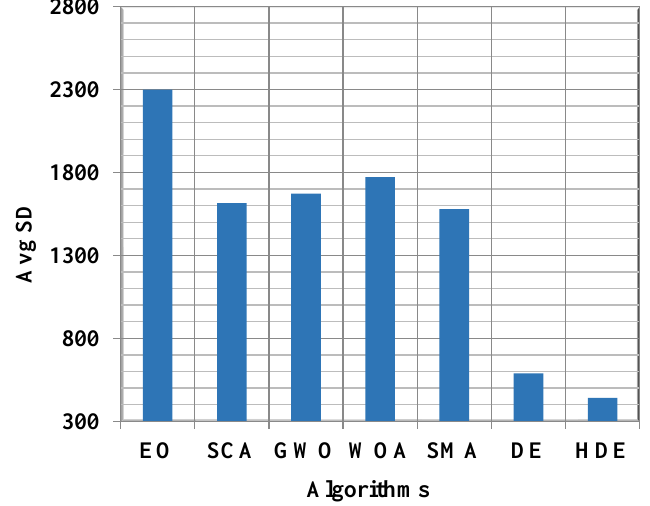
Figure 7. Comparison with metaheuristics in terms of the average SD of makespan.